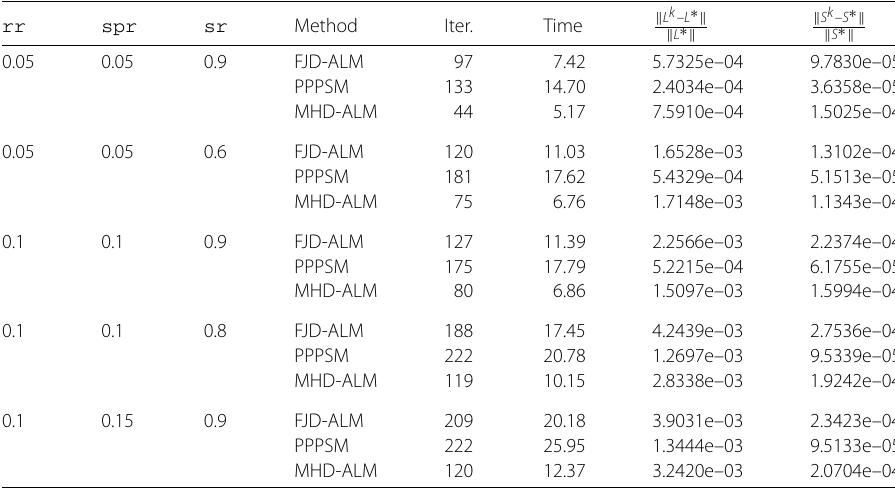
Table 1 Numerical comparisons between different algorithms for p = q = 500 rr spr sr Method